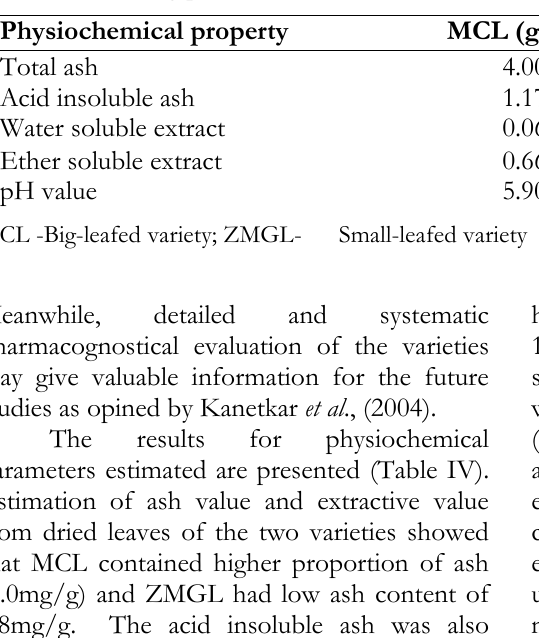
Table IV. Showing physicochemical analysis of the two line of G. sylvestre leaf